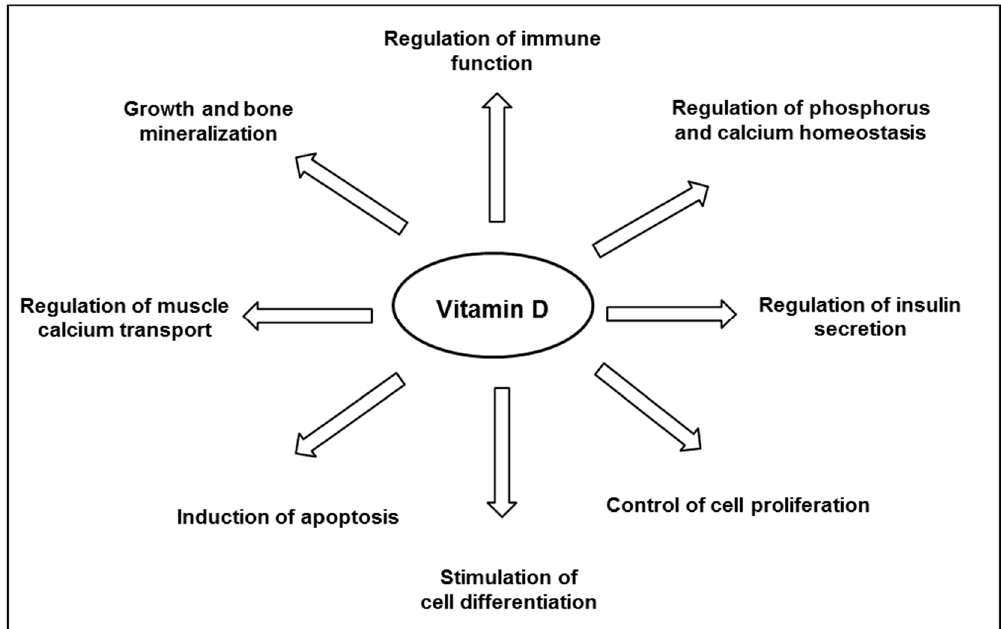
Figure 2. Major biological functions of vitamin D.